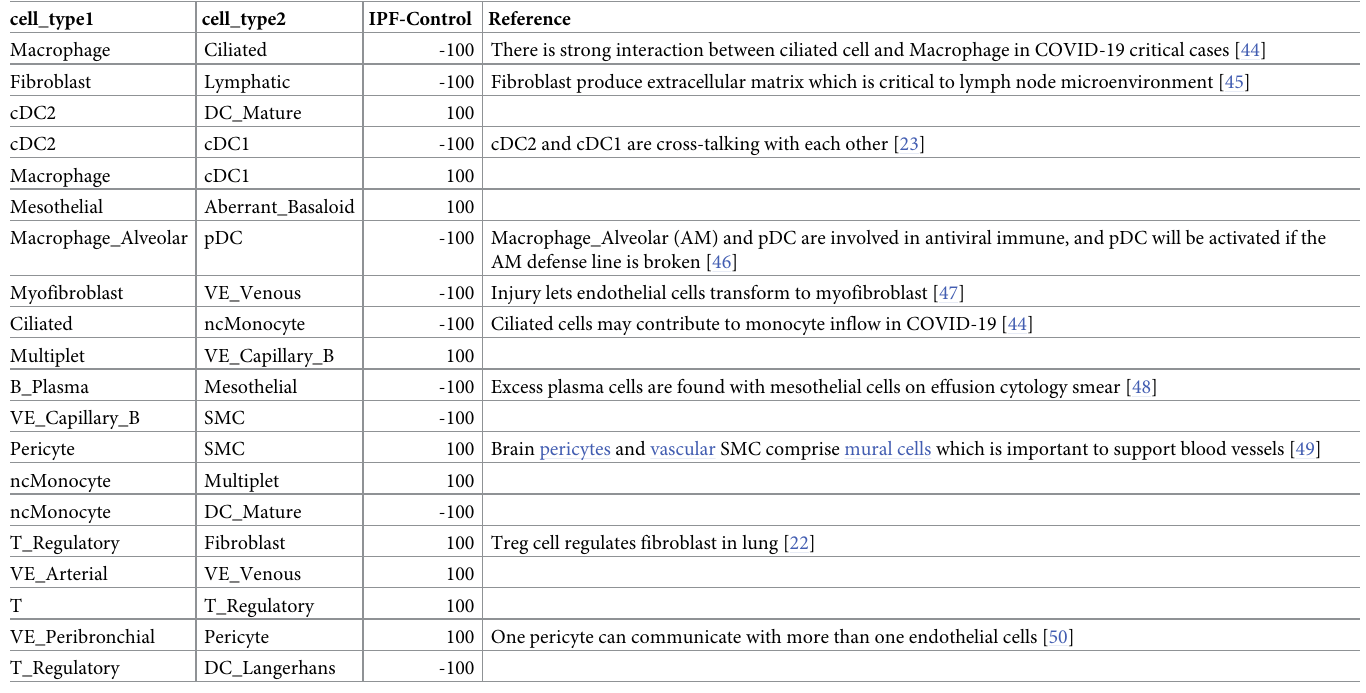
Table 1. Top differential cell type interactions identified by CINS for the IPF dataset. The IPF-Control column lists the difference in the number of times the edge between the two cells was identified in 100 bootstrap runs for each of the two datasets. Negative values indicate that it was identified more for the Control whereas positive numbers mean that the interaction is more prevalent in IPF. For all listed edges the interaction was only identified in one of the two datasets (score of 100 or